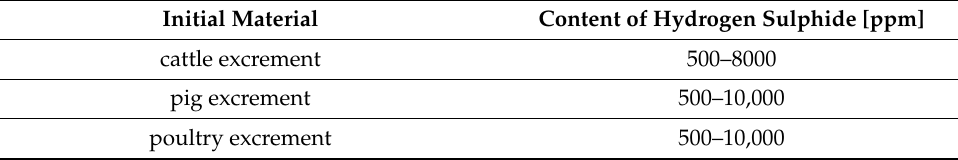
Table 2. Content of hydrogen sulphide in various agricultural